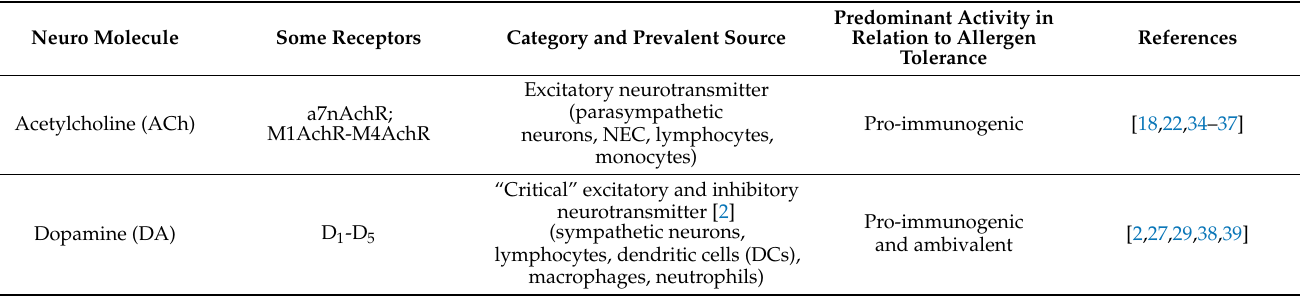
Table 2. Neuro molecules: Category, source, and functional